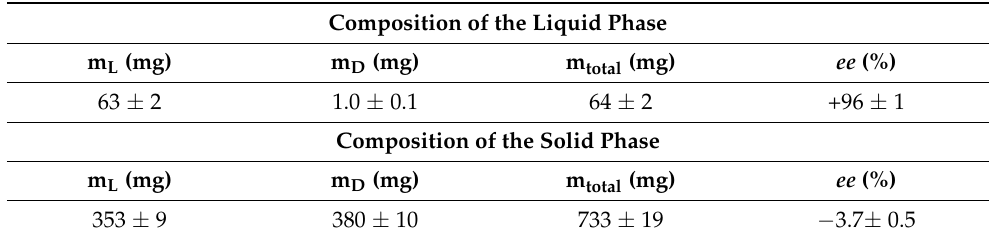
Table 1. Typical results obtained by performing the standard protocol starting with an excess of (+) 5%ee (m L : mass of L-ArgFum, m D : mass of D-ArgFum, m total : total mass of ArgFum). Composition of the Liquid Phase m L (mg) m D (mg) m total (mg) ee (%) 63 ± 2 1.0 ± 0.1 64 ± 2 +96 ± 1 Composition of the Solid Phase m L (mg) m D (mg) m total (mg) ee (%) 353 ± 9 380 ± 10 733 ± 19 − 3.7 ±